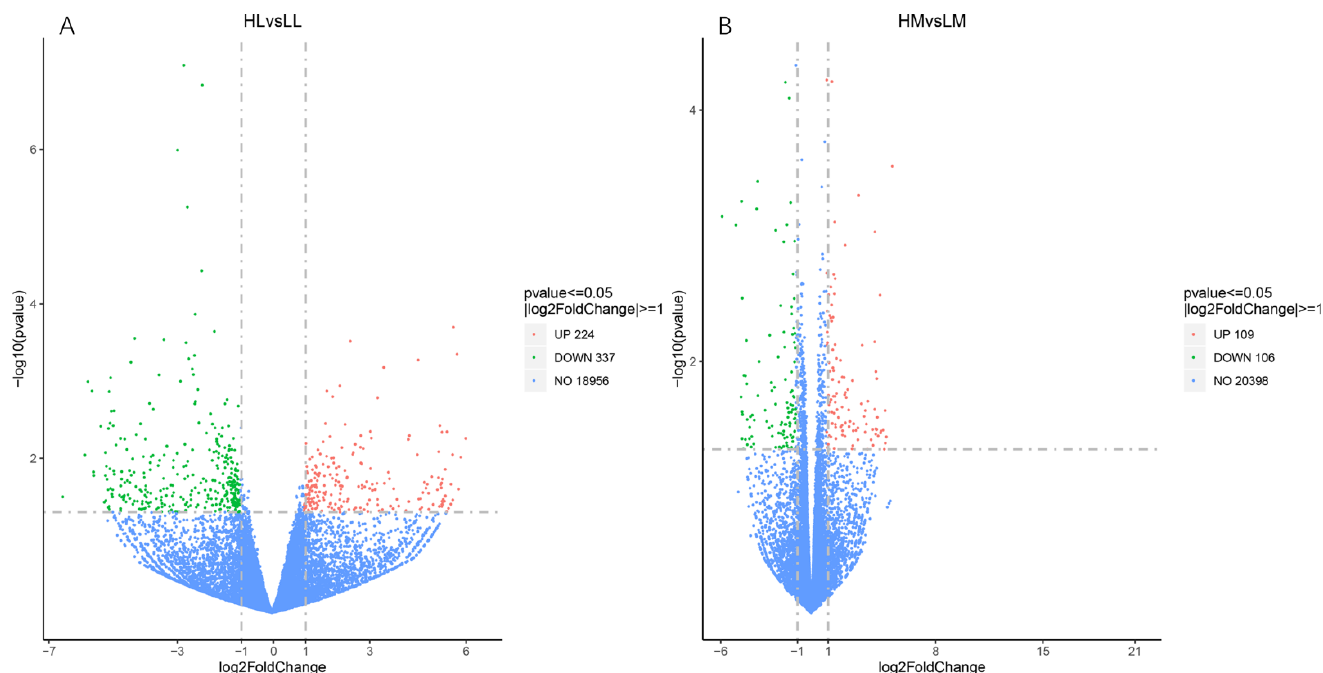
Figure 1. Volcano plot of the genes differentially expressed between HL vs. LL ( A ) and HM vs. LM ( B ) groups. The green dots represent the significantly over-expressed genes in the HL/HM group; the red dots represent the significantly under-expressed genes in HL/HM group; and the blue dots represent the genes whose expression levels did not reach statistical significance.